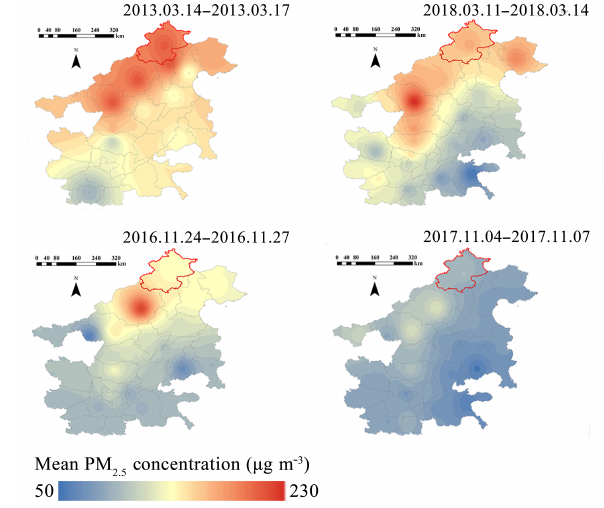
Figure 6. The distribution of PM 2 . 5 concentrations in the 2 + 26 region during four pollution